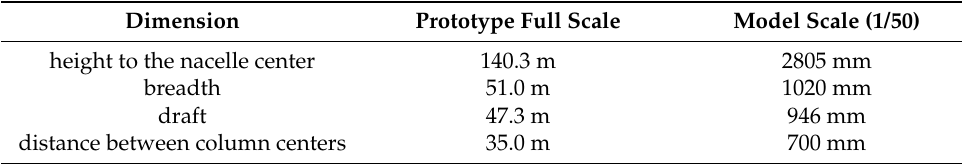
Table 2. Main dimensions of the floater.